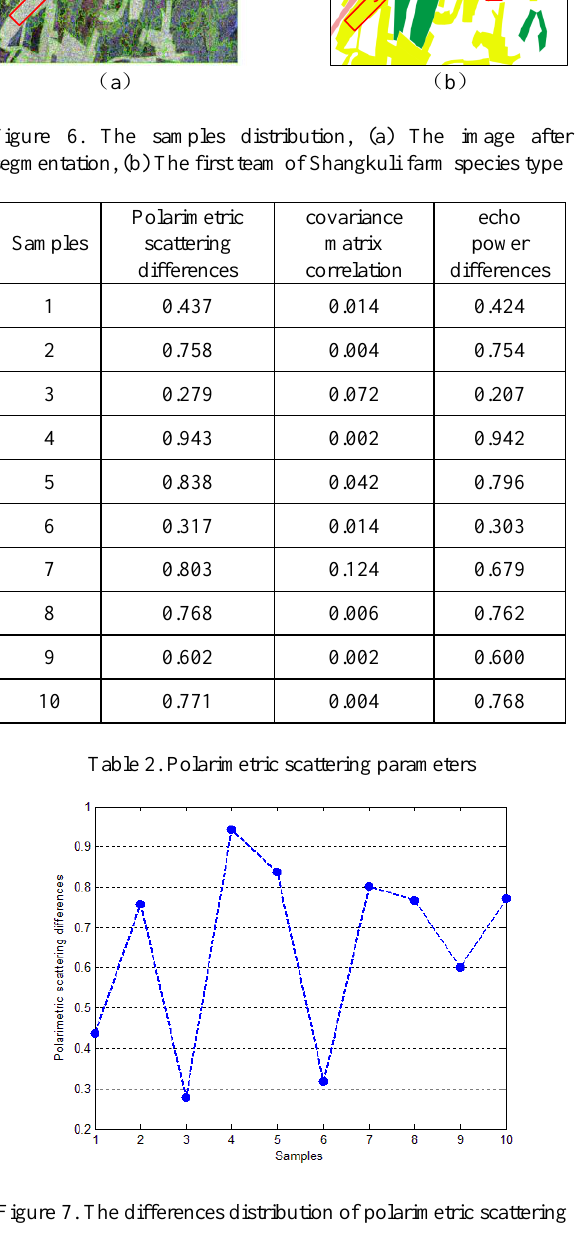
Figure 7. The differences distribution of polarimetric scattering The distribution of polarimetric scattering difference is utilized to analyse the change of objects. The automatic threshold is 0.752 in the process of change detection. The patches are detected as changed objects are samples 2, 4, 5, 7, 8, 10, which combined with the change detection results (Figure 6 (d)) and the polarimetric scattering diversity (Figure